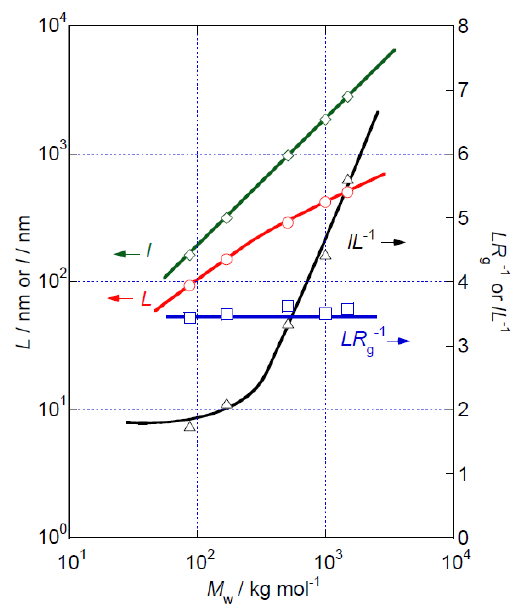
Figure 4. M w dependencies of L , LR g −1 and lL −1 for HeC samples in aqueous solution at 25 °C. Lines are drawn in this figure as a guide for the eye.